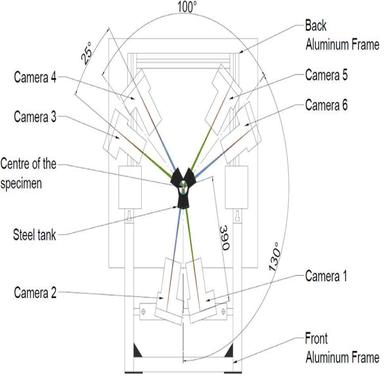
The digital image correlation (DIC) setup for testing an anterior cruciate ligament. (a) Schematic view of the DIC setup around the tensile testing machine. (b) Complete built of the DIC setup showing all six cameras, stainless-steel tank and the specimen submerged in 20 ml buffer solution (15 ml of 20 mM Tris pH 7.5, 150 mM NaCl, 5 mM CaCl2) with protease inhibitors (1 tablet of mini-cOmplete per 10 ml of buffer, SIGMA-ALDRICH/Roche, USA).